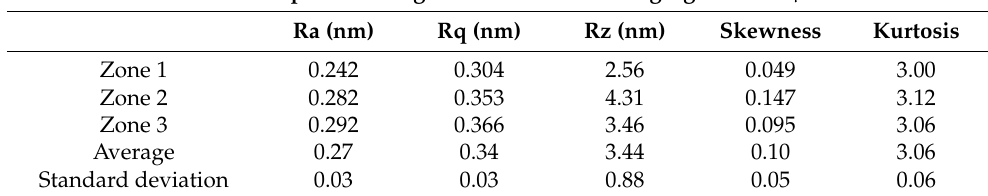
Table 6. 2D Roughness parameters were calculated from the 1 × 1 µ m 2 field of view images obtained by AFM of Zone 1, Zone 2 and Zone